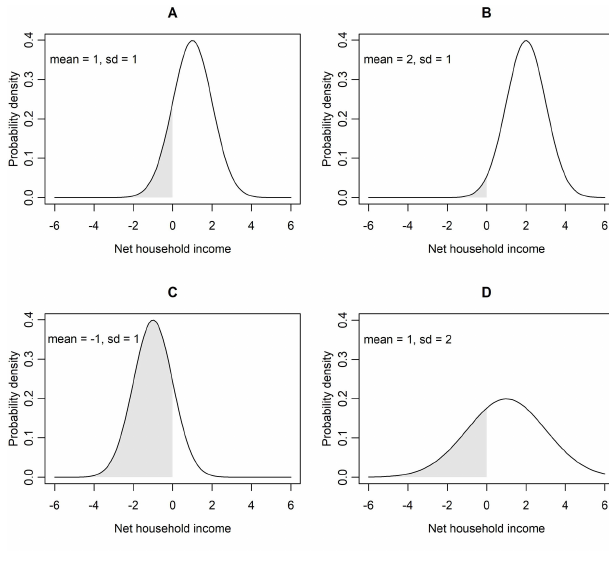
Fig. 1 . Schematic representation of household livelihood vulnerability, defined here as the probability of falling under an income threshold (e.g., zero). This corresponds to the shaded area under the income distribution curve left of the threshold (Fig. A). The diagrams represent income distributions with different mean and standard deviation (sd). For a given sd, vulnerability decreases with increasing mean income (Fig. B) and increases with decreasing mean income (Fig. C). For a given mean income, vulnerability increases with higher income variability (Fig.